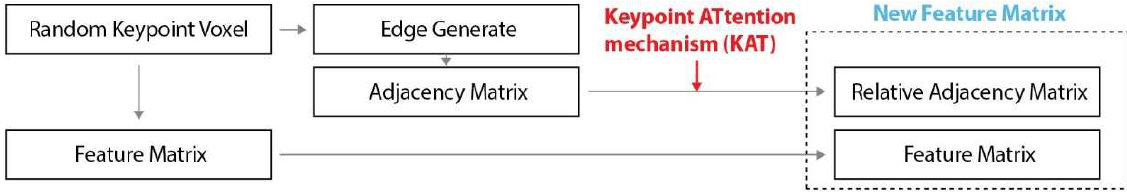
Figure 2. Keypoint extraction and conversion to graph matrices.